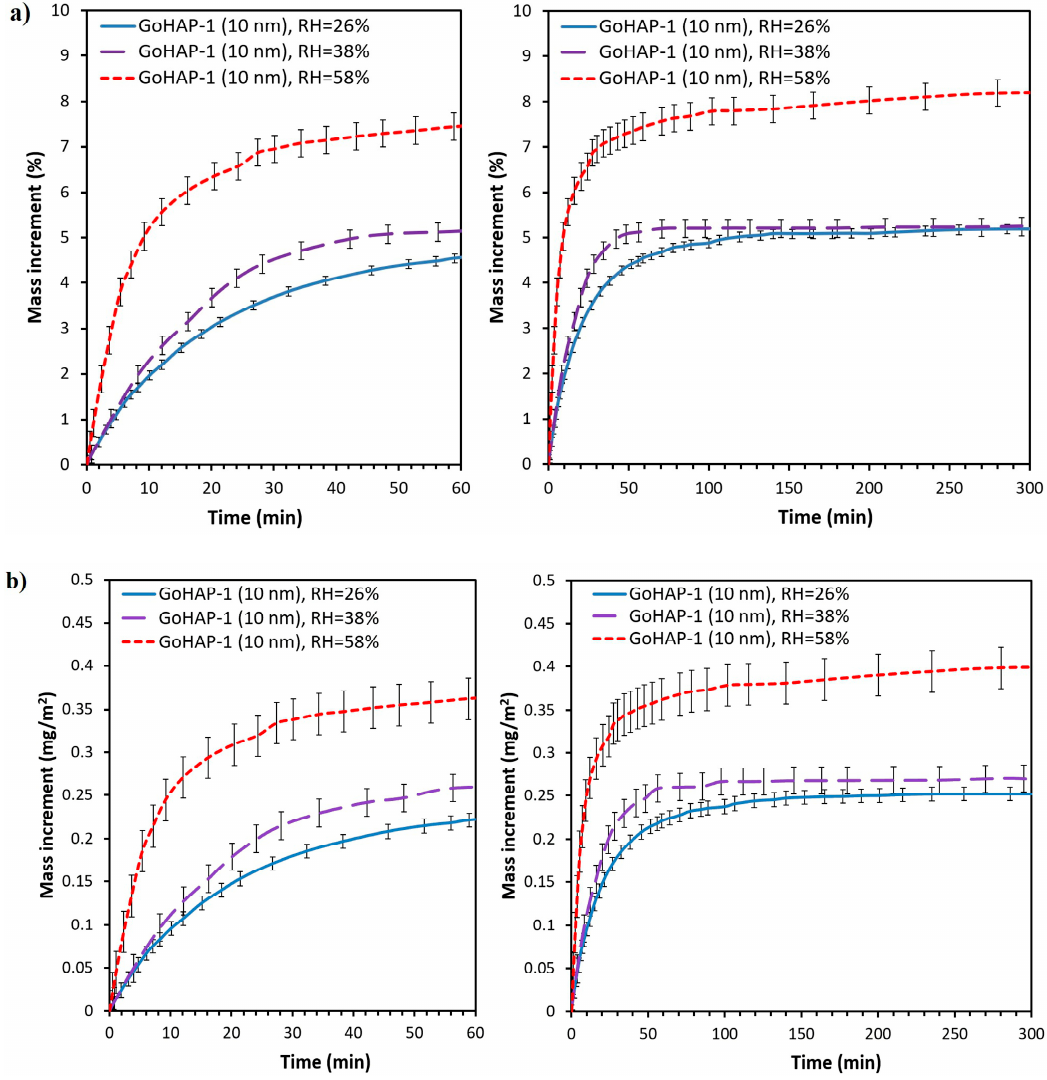
Figure 6. Kinetic curves of water adsorption on GoHAP-1 (10 nm) with varied ambient relative humidity values: ( a ) percentage mass change, ( b ) mass increment per 1 m 2 . humidity values: ( a ) percentage mass change, ( b ) mass increment per 1 m 2